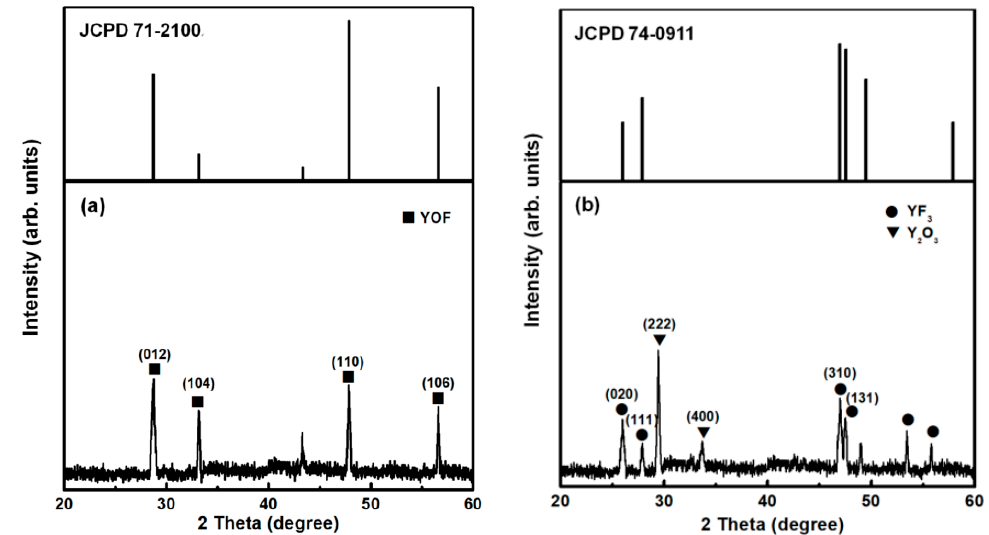
Figure 2. XRD patterns of ( a ) YOF and ( b ) yttrium fluoride (YF 3 ) coating deposited on an Al substrate.